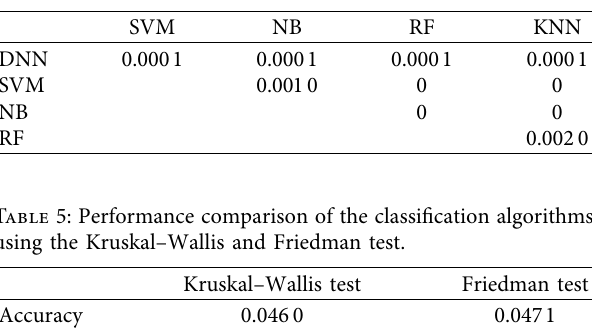
Table 4: Performance comparison of the classification algorithms using 5 × 2 cv paired t -test.